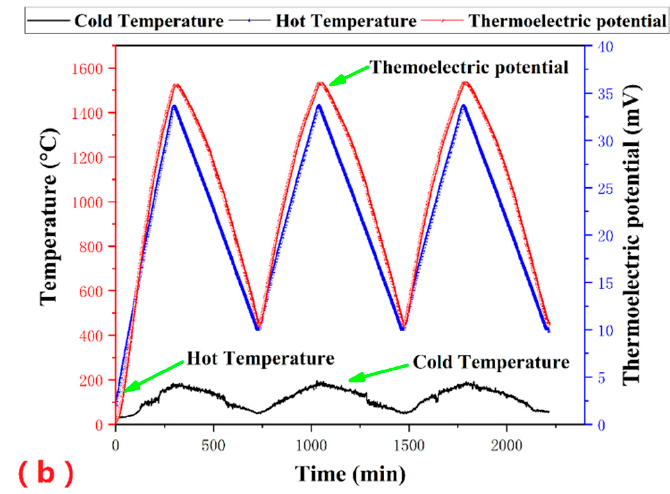
Figure 7. Thermoelectric output of tungsten-rhenium TFTCs in heating at 700 °C ( a ), and in cycle of heating and cooling with a peak hot junction temperature of 1420 °C ( b ).